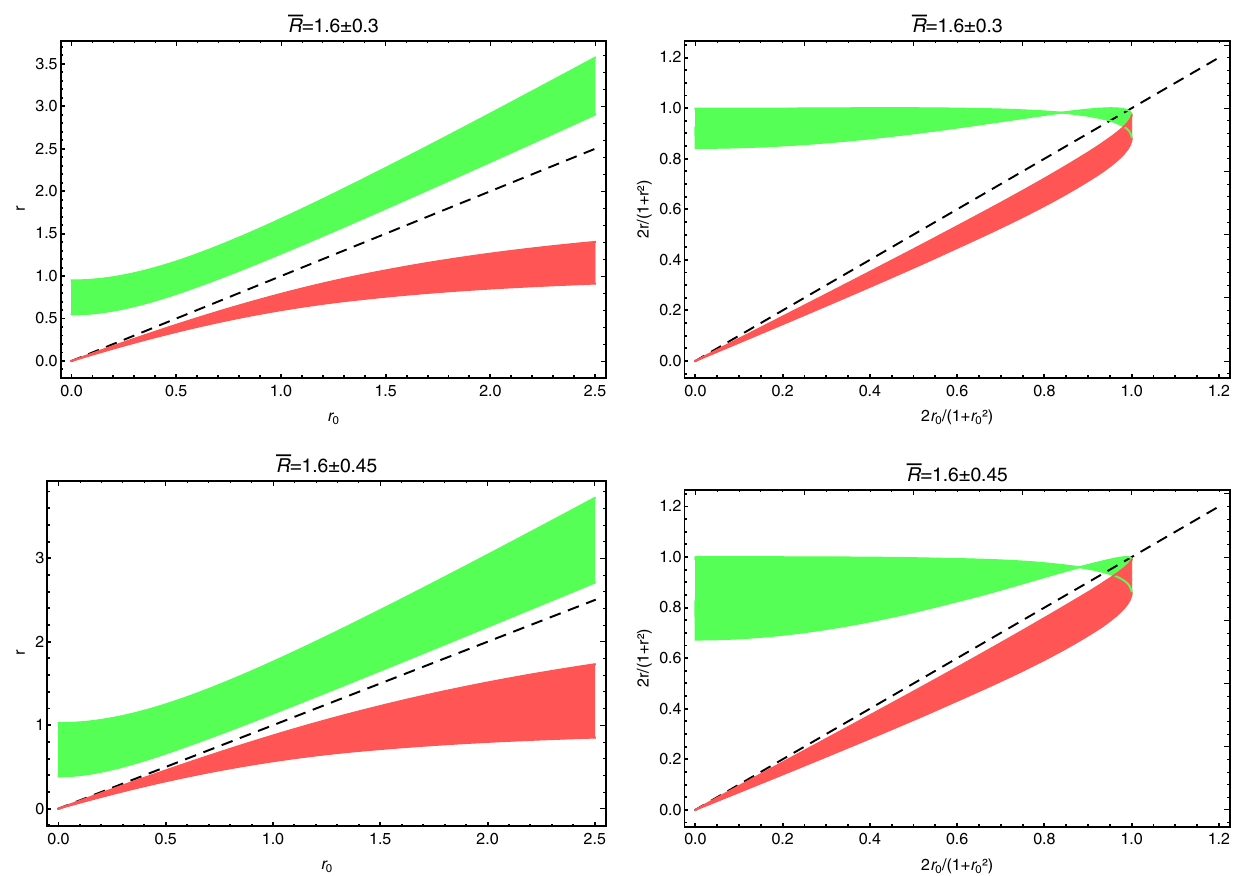
(cid:8) 0 (red, lower band). The upper (lower) 7